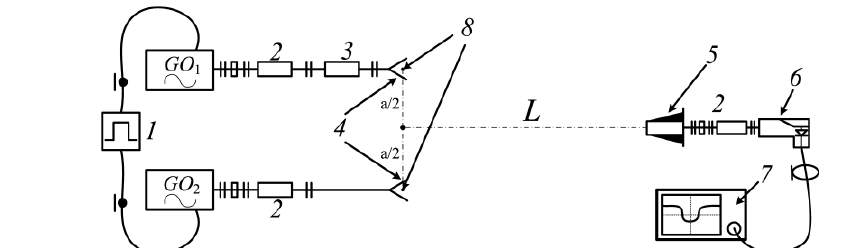
Figure 8 – Experimental setup of a wave field measurement of an antenna system